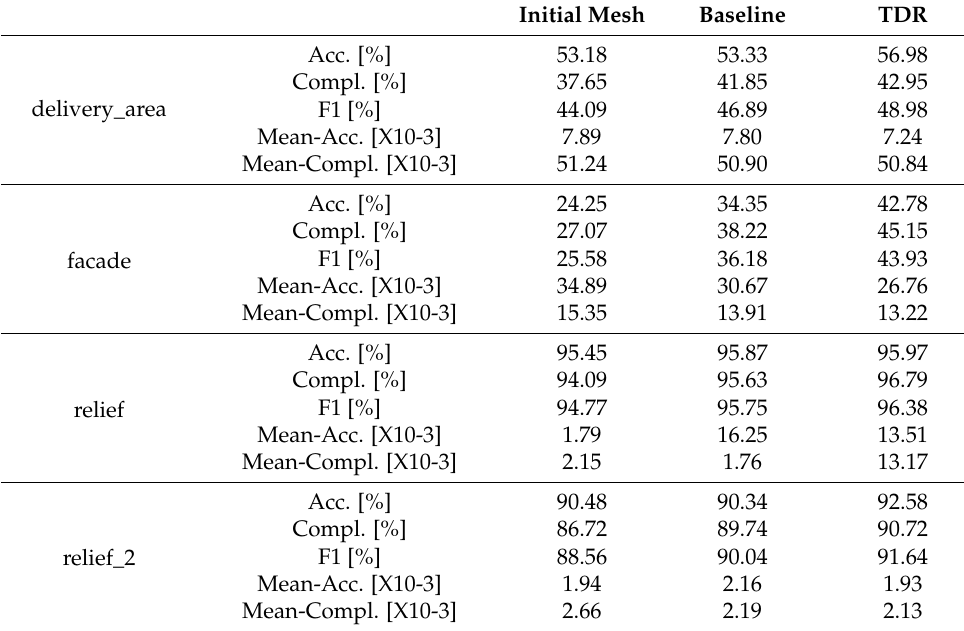
Figure 8. Visual comparison of results on the ETH3D dataset. Table 3. Quantitative evaluation of results on the ETD3D dataset.